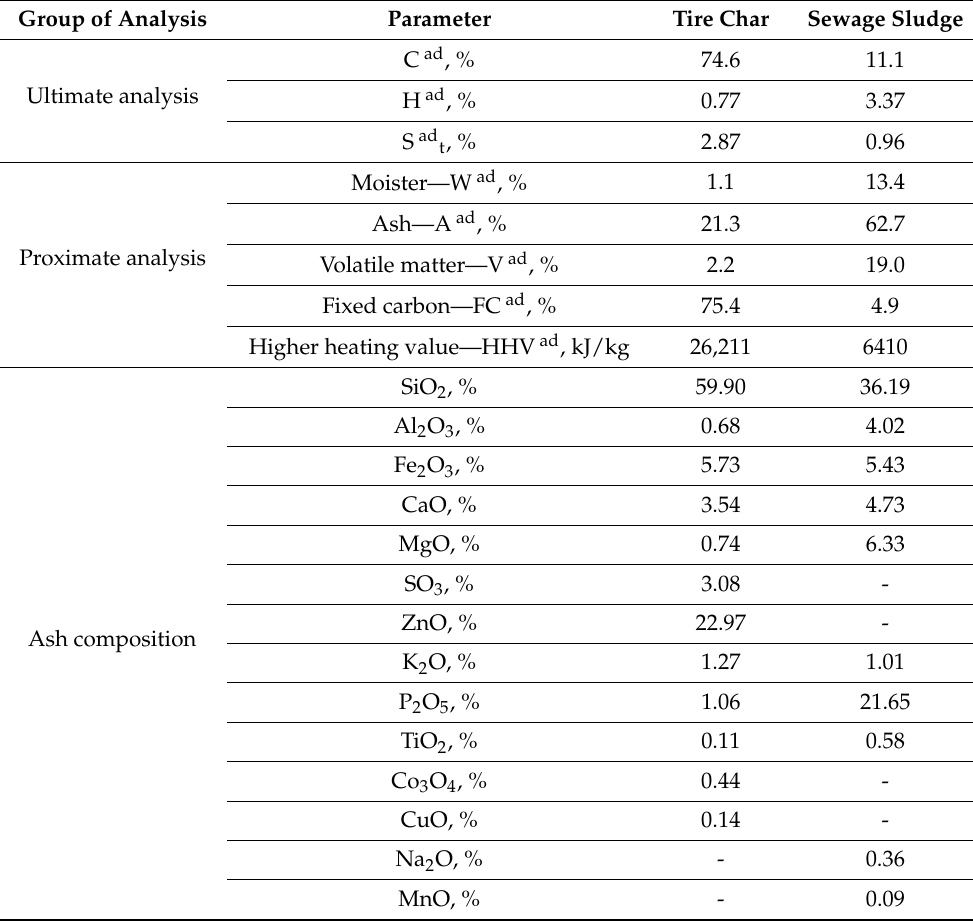
Table 1. Characteristics of the tested